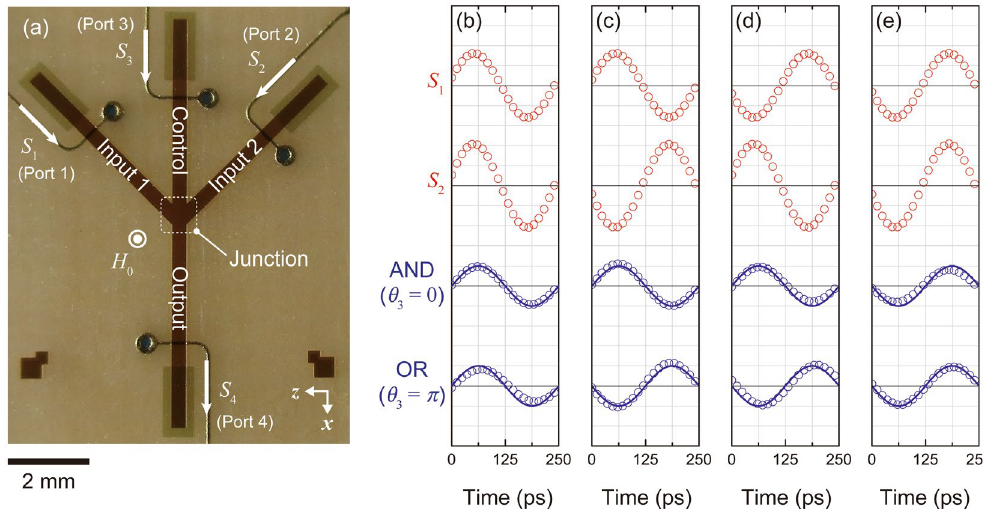
Figure 1. Magnonic majority gate realized by Ψ -shaped spin wave interferometer. ( a ) Overview of fabricated Ψ -shaped interferometer. Waveguide ends are covered by 10-nm-thick gold. Signals S 1 , S 2 , and S 3 represent input waves, and S 4 represents the output wave. All signals can be written in the sinusoidal form as S i = A i sin( ω t + θ i ), and are given by microstrip lines with short termination. Input and output waveforms with different injection phases are also displayed: ( b ) ( θ 1 , θ 2 ) = (0, 0), ( c ) (0, π ), ( d ) ( π , 0), and ( e ) ( π , π ). Red circles represent input waveforms S 1 and S 2 , blue circles represent output waveform S 4 , and bold lines represent theoretical curves calculated with A i = 10 mV peak to peak. Vertical grid corresponds 50 mV/div. for red circles, and 5 mV/div. for blue circles except for θ 3 = 0 in (b) and θ 3 = π in ( e ). These waveforms are visualized in 15